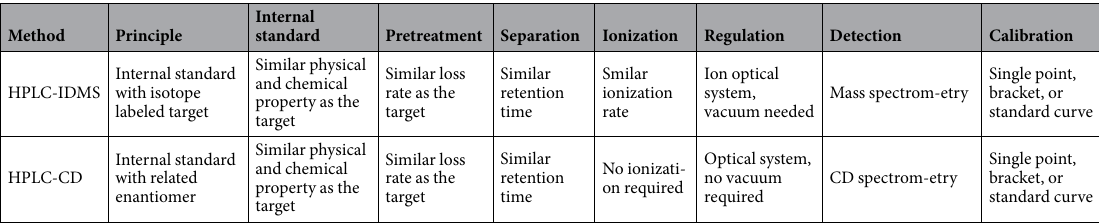
Table 5. Comparison of the proposed method with traditional IDMS